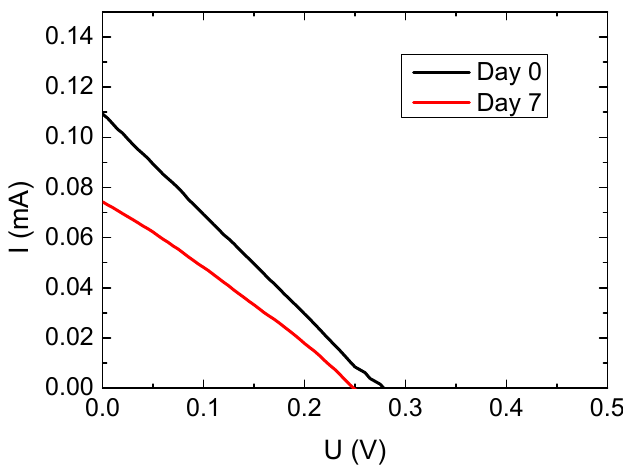
Figure 4. Current-voltage ( I - U ) characteristics of a pure nanofiber mat DSSC, prepared with an anthocyanin-based dye. The y-axis is identical with Figure 3.